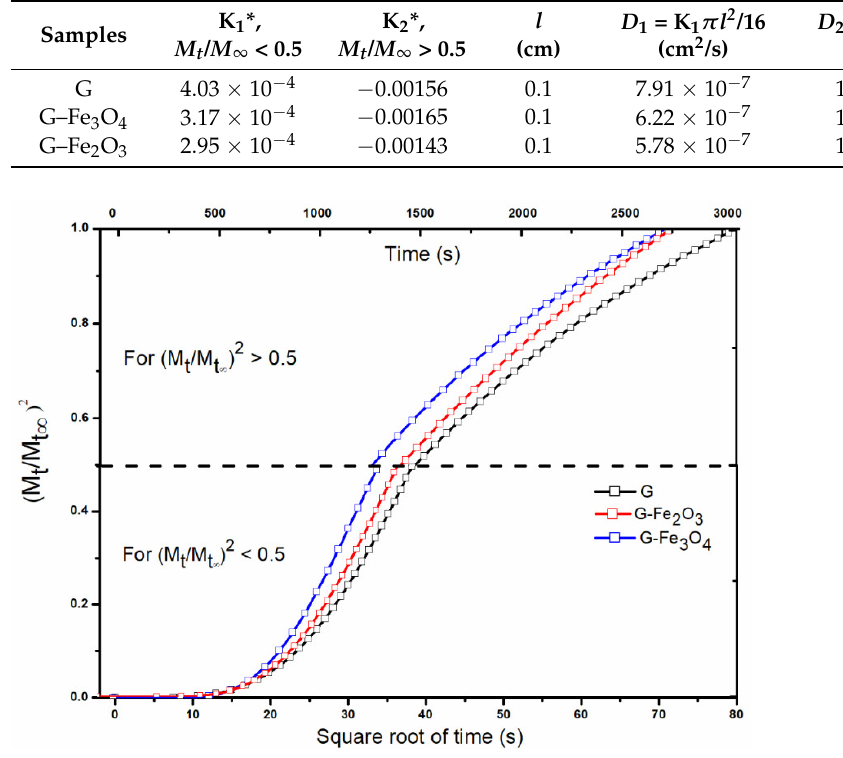
Table 4. The diffusion coefficients determined based on the experimental data for the analyzed samples.